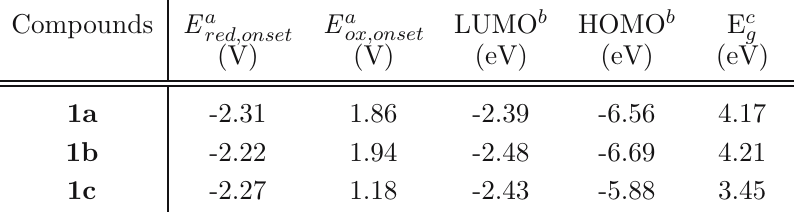
Table 3 The electrochemical properties of 1a-c .